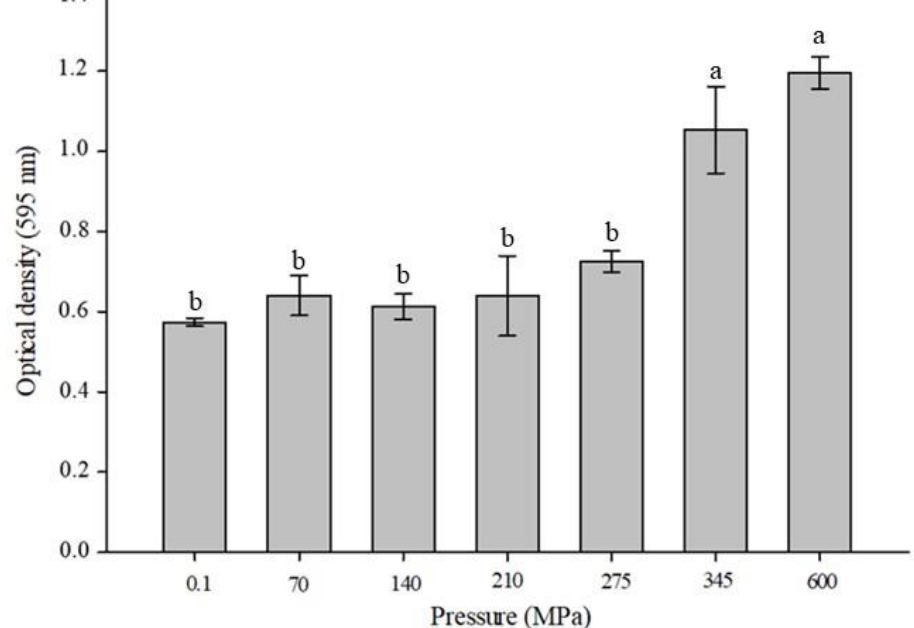
Figure 2. Optical density (OD 595 nm) of control (0.1 MPa) and pressure-treated (70–600 MPa for 5 min) mealworm protein samples at 10% ( w / v ). The data represent mean values of triplicates ± standard deviation. Multiple means comparisons were performed between pressure treatments (one-way ANOVA, multiple comparison, Tukey test, α = 0.05). Different lowercase letters (a and b) indicate mean values with significant differences.